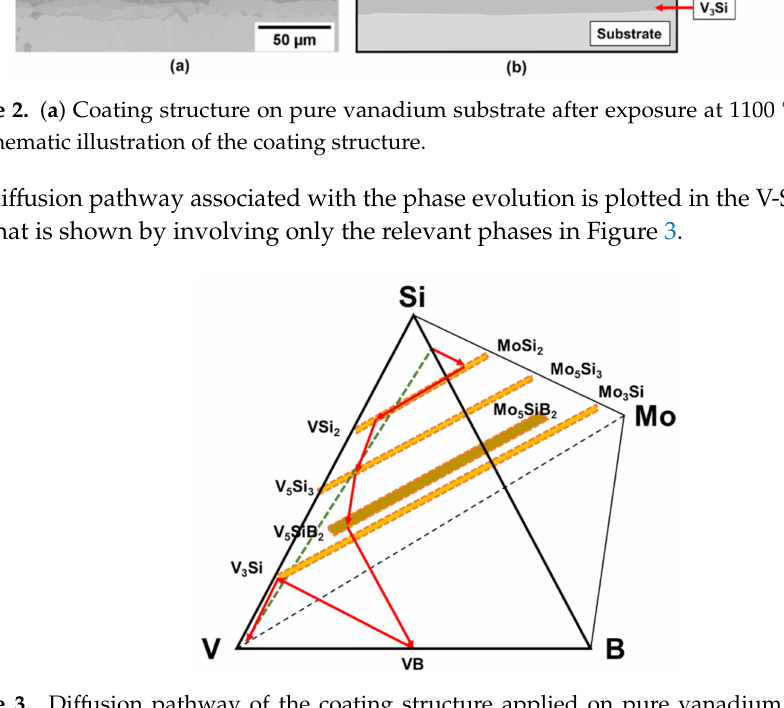
Figure 3. Di ff usion pathway of the coating structure applied on pure vanadium plotted on the quaternary isotherm at 1100 ◦